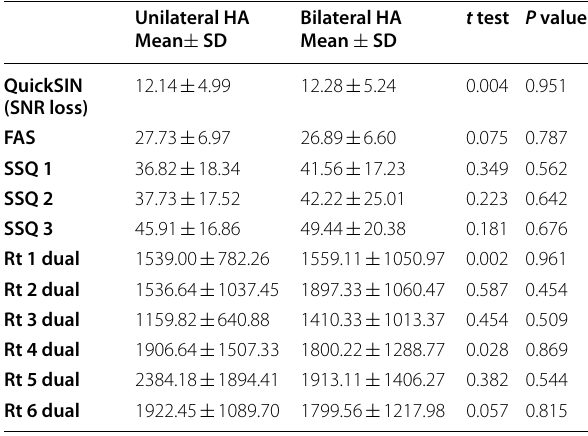
Table 3 Comparison of hard task (Stroop test) answers between the control and study subgroups